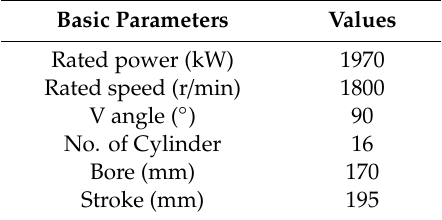
Table 1. Basic parameters of the diesel